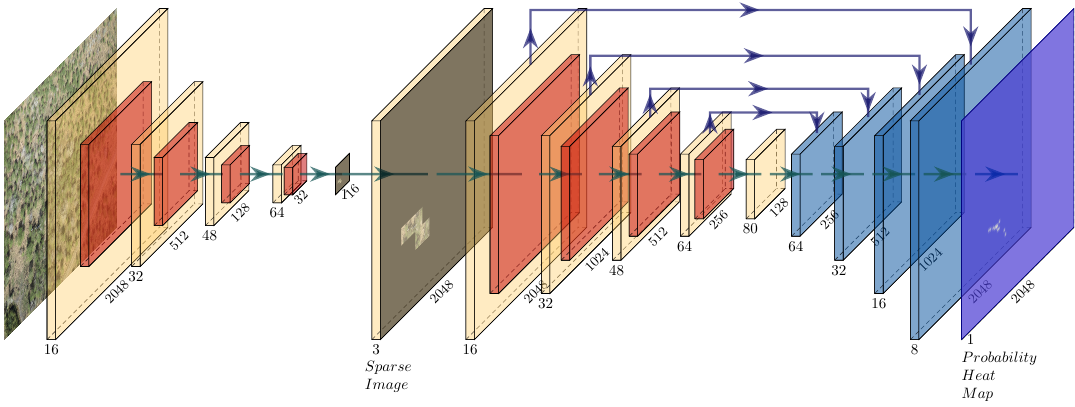
Figure 2. Our DisCount network: An end-to-end learning framework for counting sparse objects in high-resolution images. It includes two networks: The first network (DiscNet) will select regions and the second network (CountNet) will count the objects inside the selected regions. Convolutions are shown as transparent orange, pooling layers are represented in transparent red, and transposed convolutions are shown in transparent